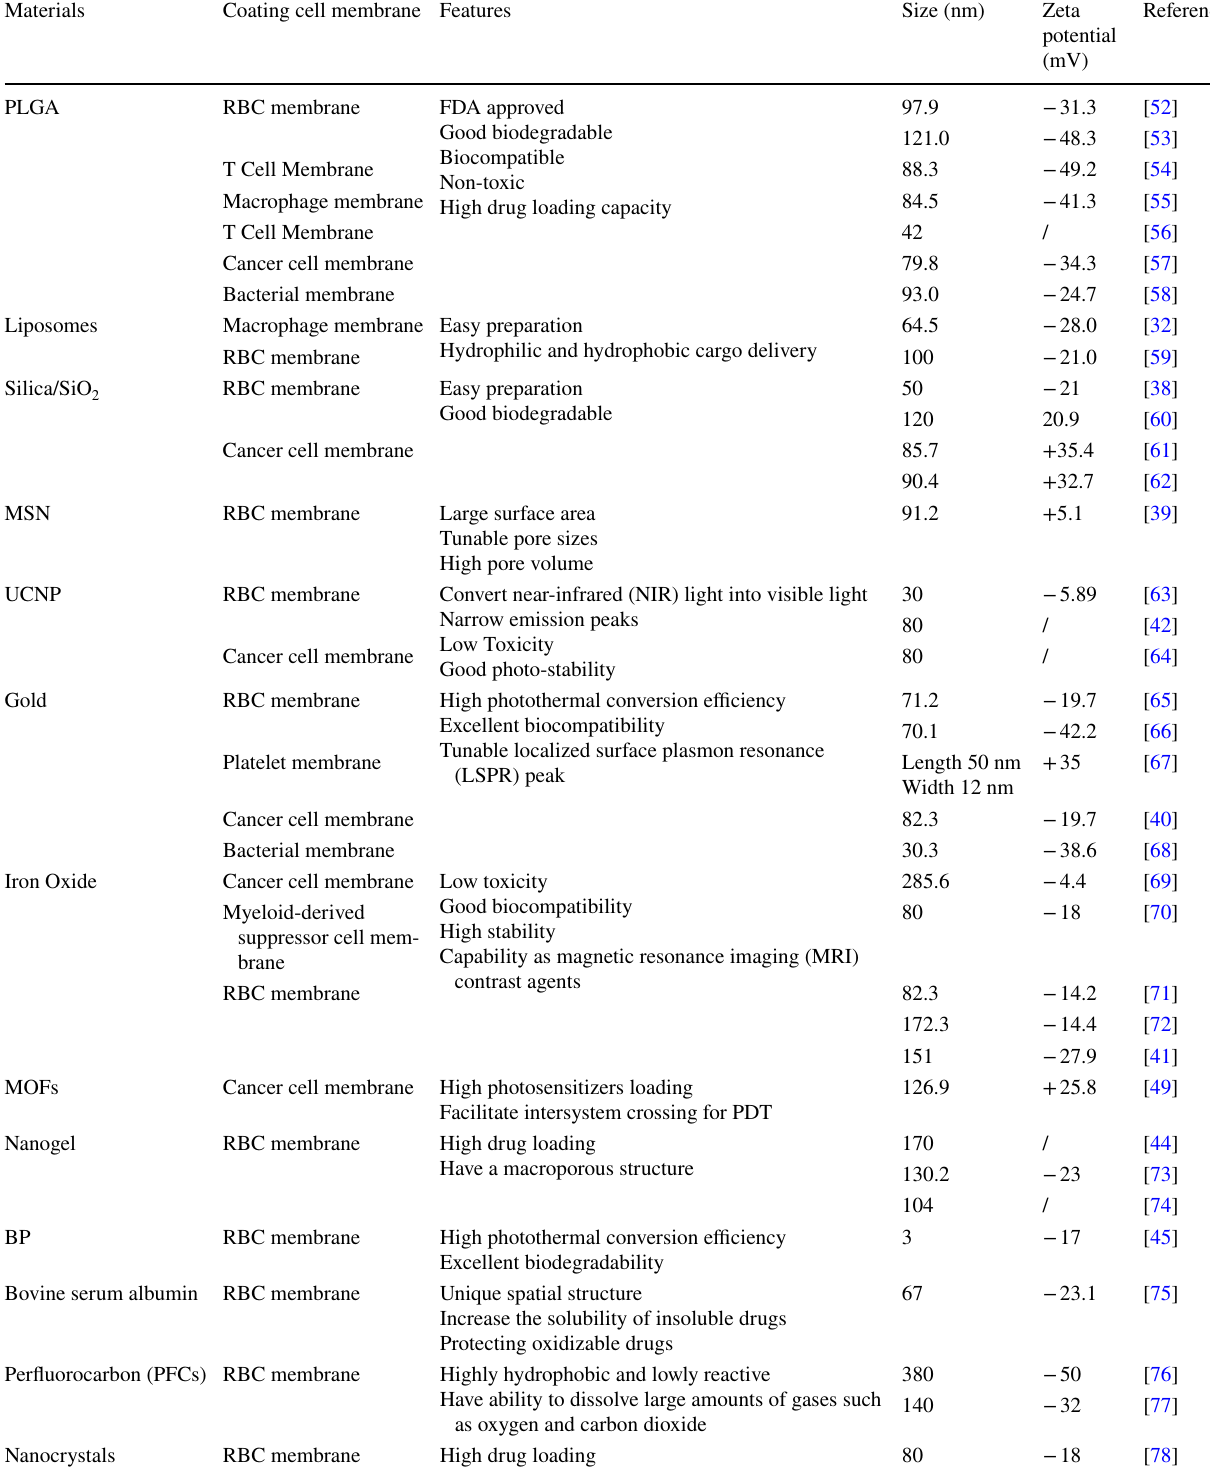
Table 2 Inner core nanocarriers for cell membrane coating approaches